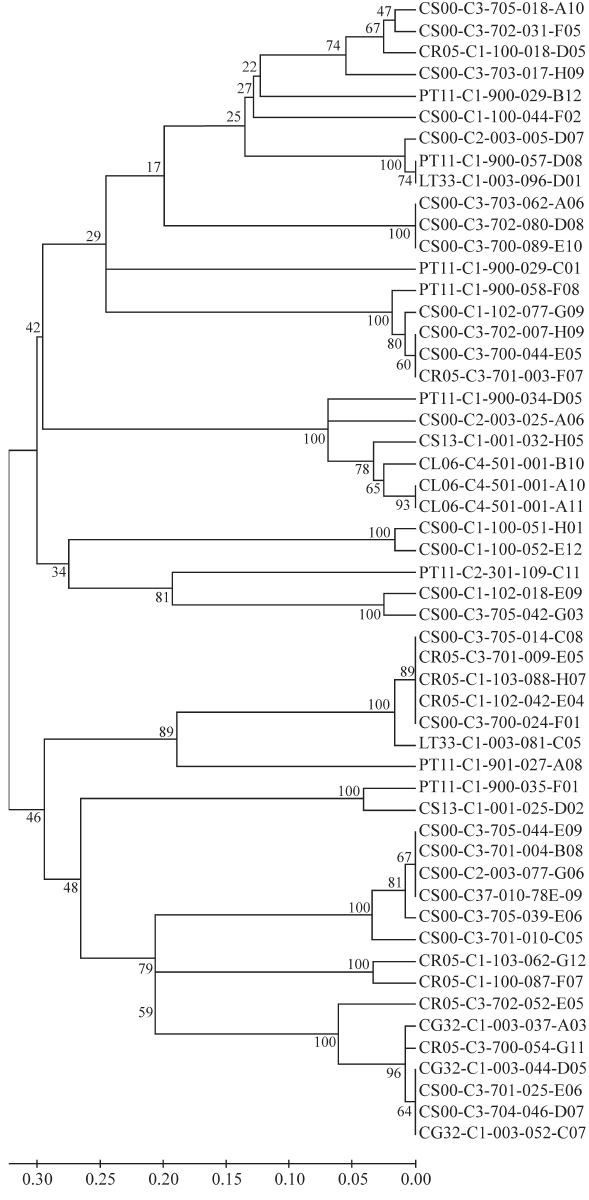
Figure2 -DendrogramofASPaToriginatingfromdifferentspeciesofcit- ric plants, tissues, developmental stages, healthy or infected by